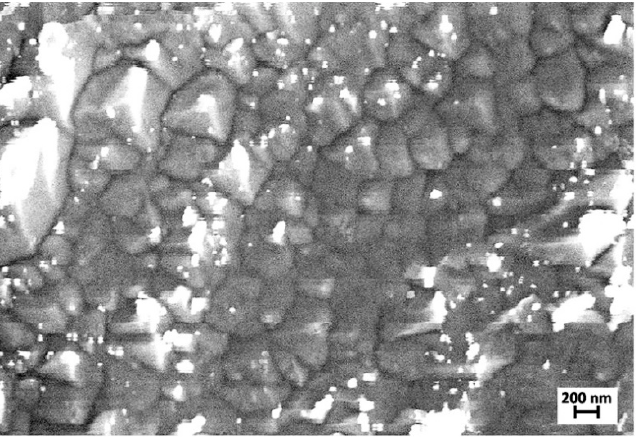
Figure 7. EUROFER97 cold-rolled with a CR ratio of 20% and heat-treated at 750 °C for 1 h.